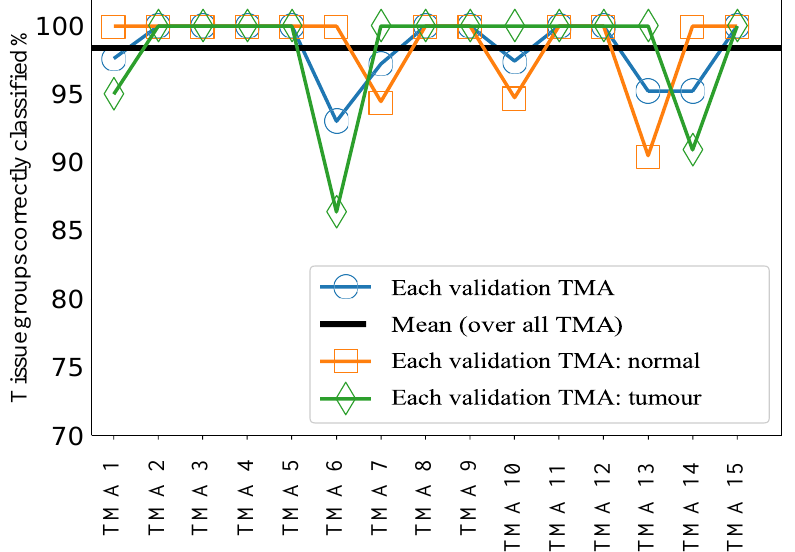
Figure 4. Colorectal cancer: Leave-one-TMA-out cross-validation results for Aim 2 (classify tissue groups): Each point shows the percentage of tissue groups on each TMA accurately classified, with different colors/markers indicating whether all tissue groups are included in the calculation, or only normal or tumour. The mean line is for the case of all tissue groups. The lines joining markers are a guide to the eye.